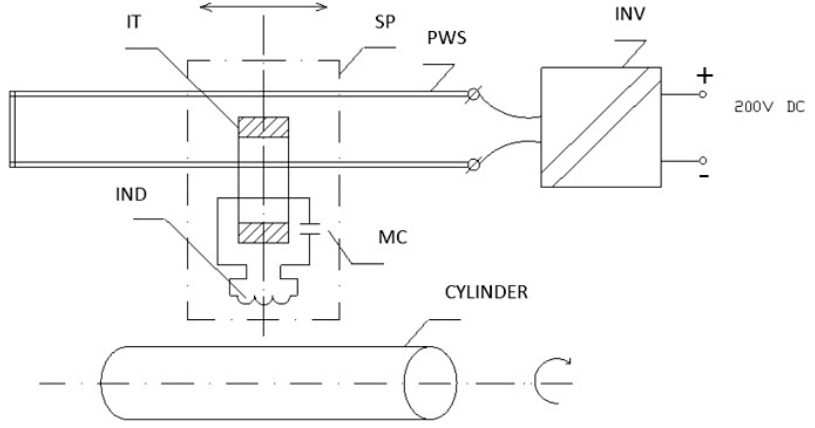
Figure 4. Electrical diagram of the wireless power supply for moving the inductors. IT—transformer core; SP—specially constructed trolley; PWS—primary winding; INV—hf inverter; IND—inductor; MC—matching condenser.